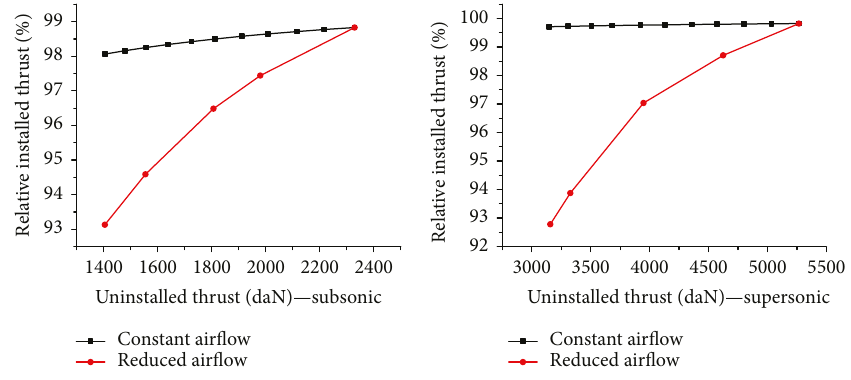
Figure 17: Variation of installed thrust during throttling.